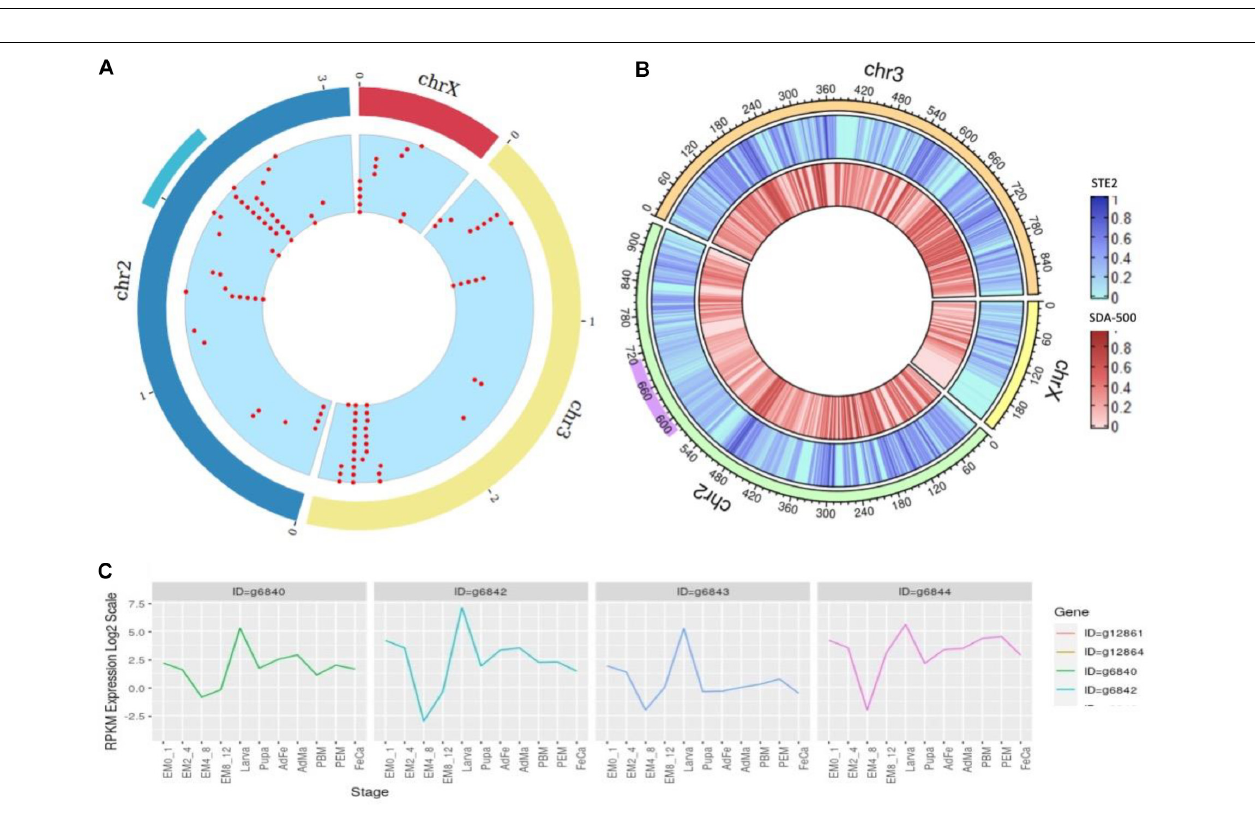
FIGURE 5 | (A) Density of cytochrome genes across the genome of An. stephensi UCI assembly, the cyan arc representing the 2Rb inversion locus and the red dots representing locations of cytochrome P450 genes across the genome. (B) SNP density at a window of 10,000 bases within STE2 (blue) and SDA-500 (red) strains compared to UCI strain (right) with purple arc showing 2Rb inversion locus. (C) Developmental expression profiles of the four copies of the CYP6a14 gene.